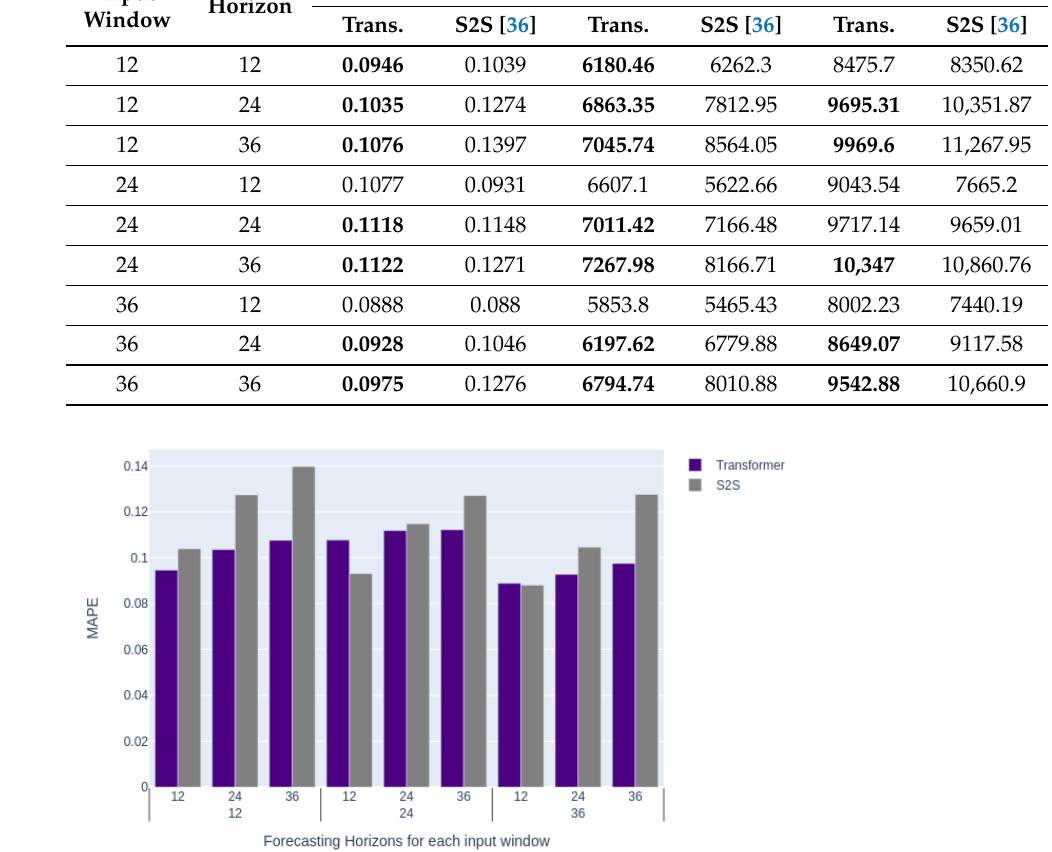
Figure 6. Average MAPE comparison over various input and forecasting horizons between the transformer model and S2S [36].